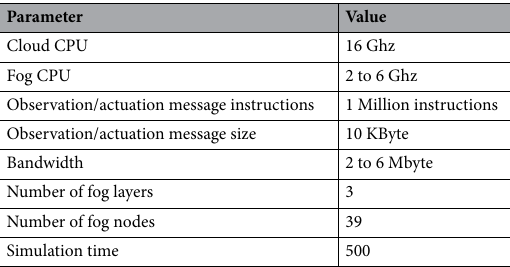
Table 2. General simulation setup parameters.